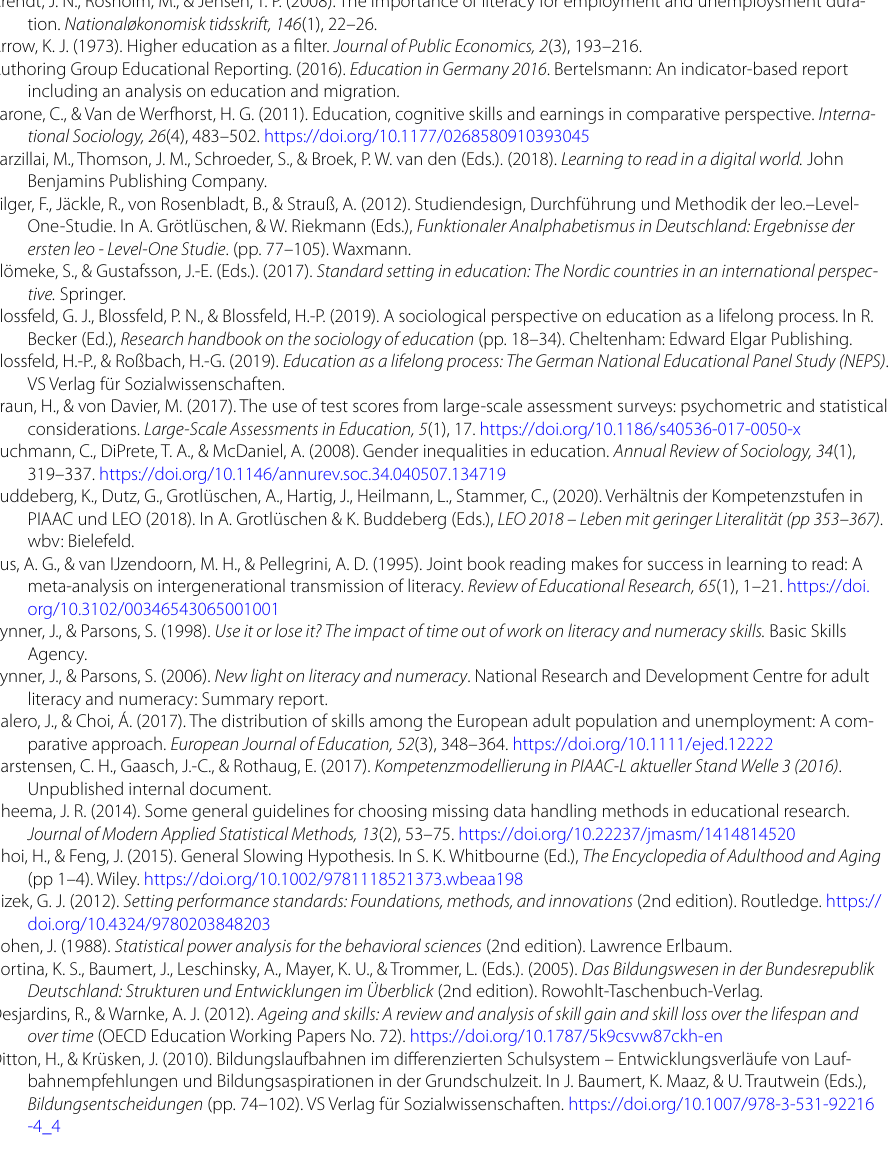
Proportion of missing values for occupational status refers to respondents in